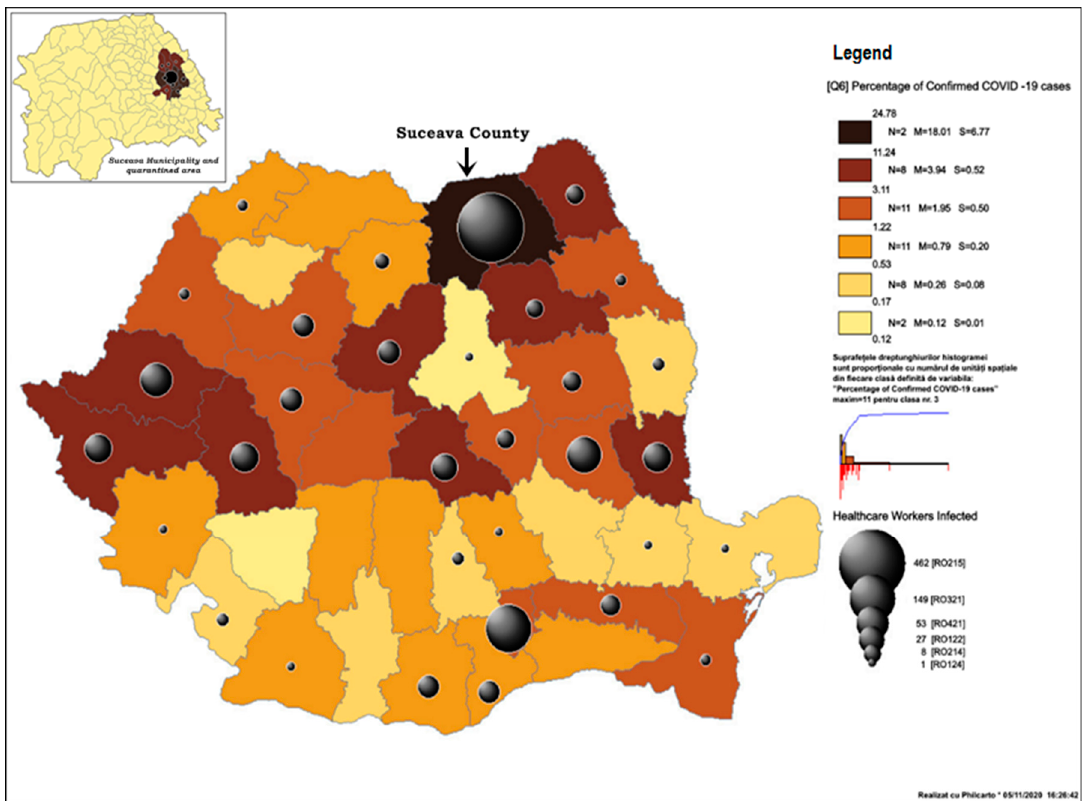
Figure 1. Confirmed COVID-19 cases per county (GCS, 16th of April 2020).